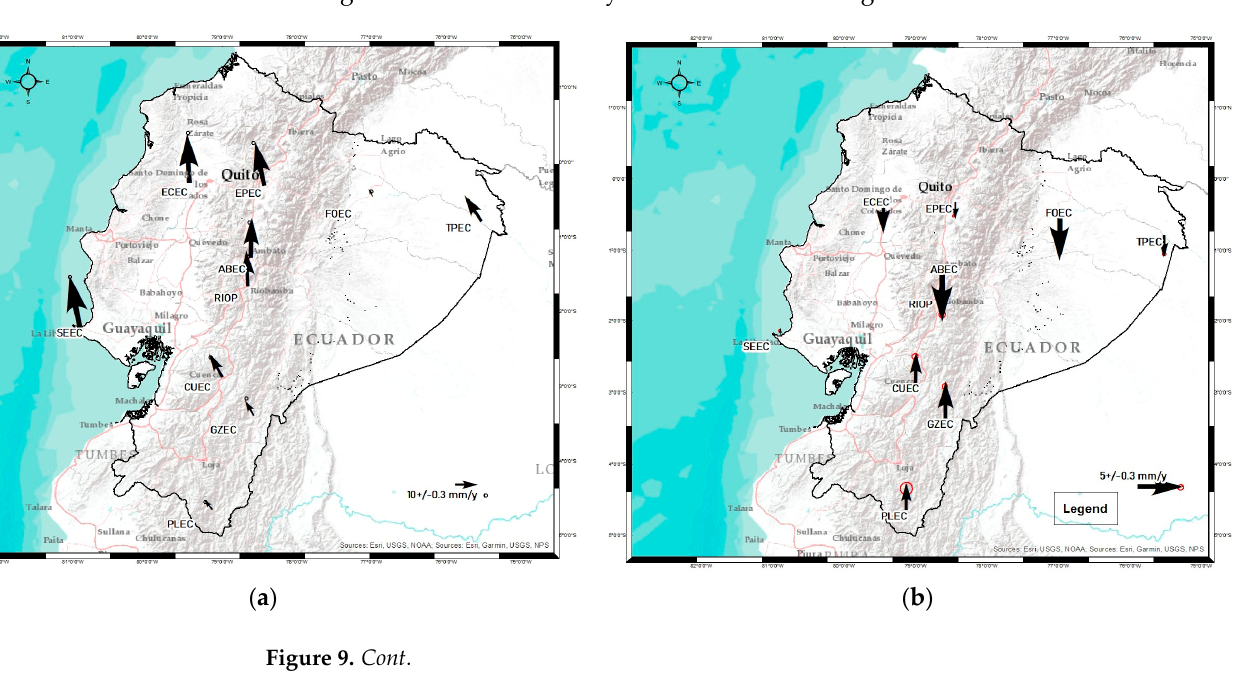
Figure 8. Final adjustment with seasonality in the time series of the EPEC station. The time series fitted is with sinusoidal components.